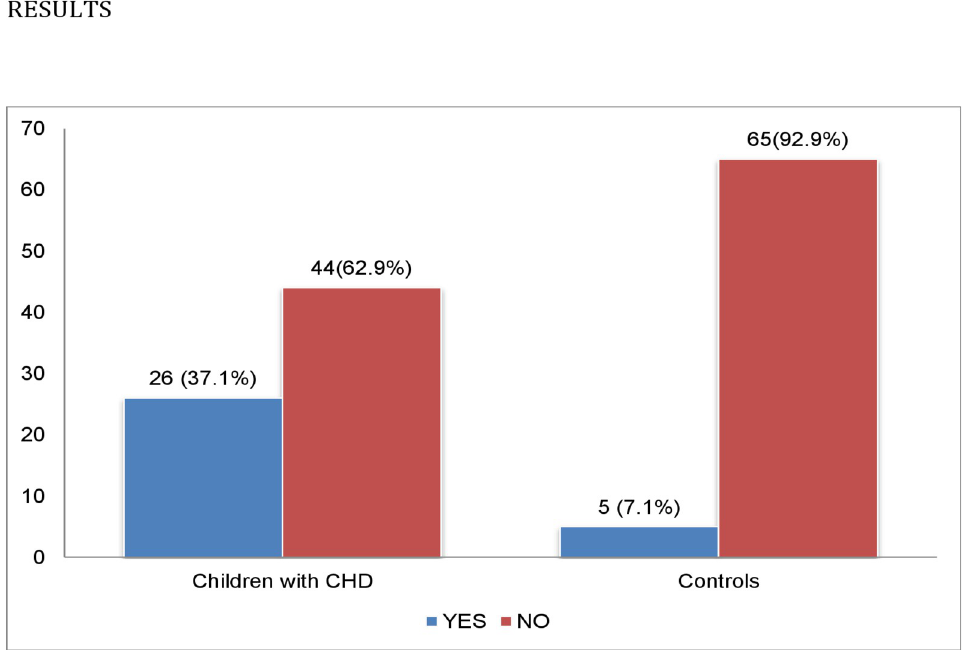
Fig 1. Prevalence of coagulation abnormalities in children with uncorrected CHD and controls.